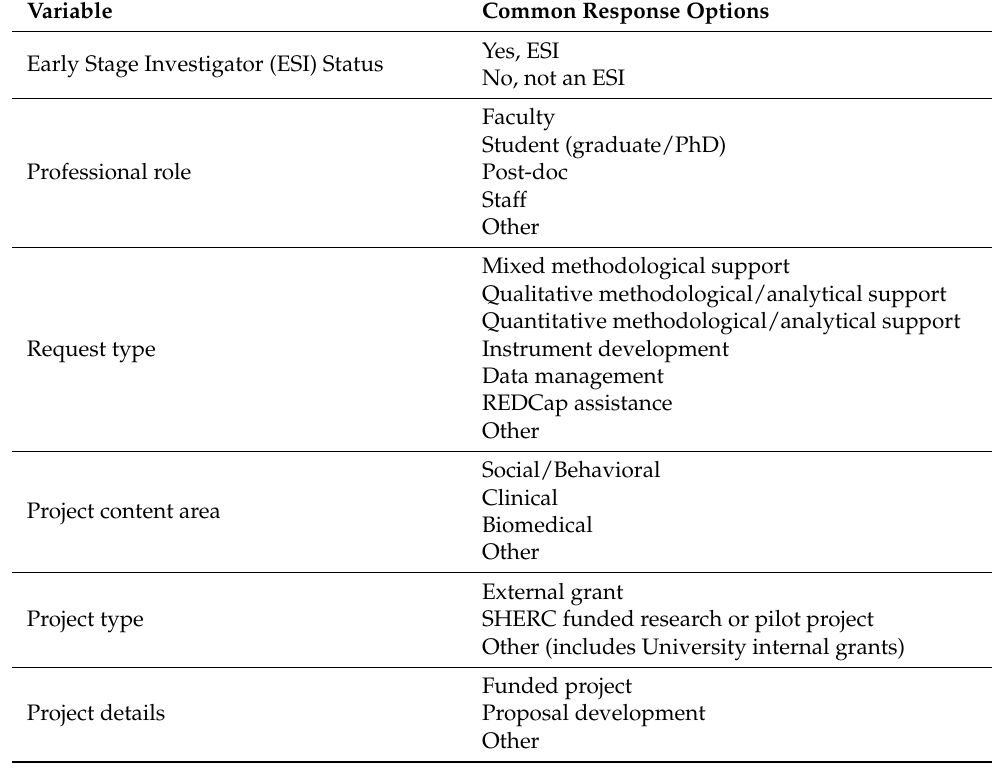
Table 2. Variables showcasing types of requests during Phases II and III TAG-SC